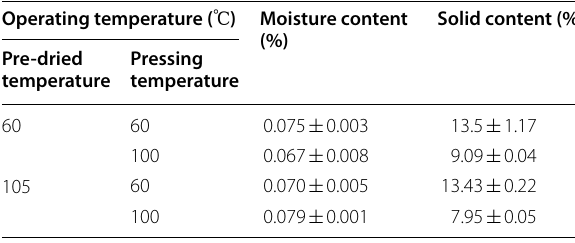
Table 3 Moisture and solid content of rubber seed oil obtained